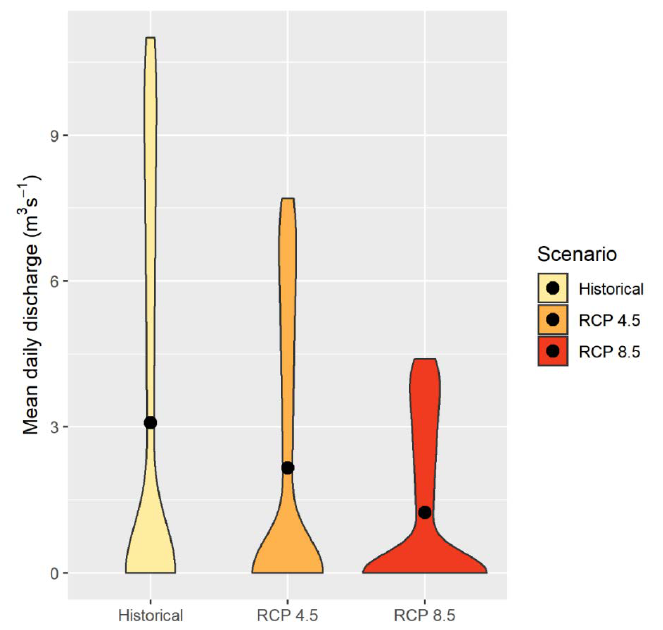
Figure 2. Density distribution of mean daily discharge (m 3 s −1 ) for the historical, RCP 4.5 and RCP 8.5 scenarios, predicted for the Pego weir, based on the climate change projections for the Tagus River.